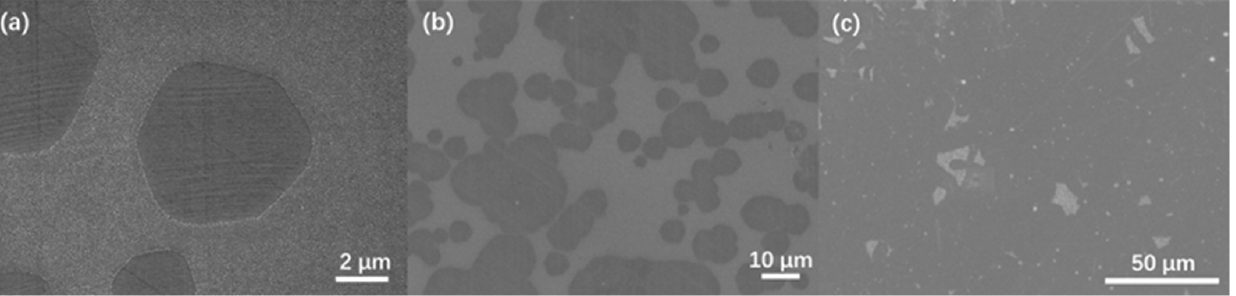
Figure 4. The SEM results of different reaction times h-BN on substrates. ( a ) 3 min, ( b ) 5 min, and ( c ) 7 min.